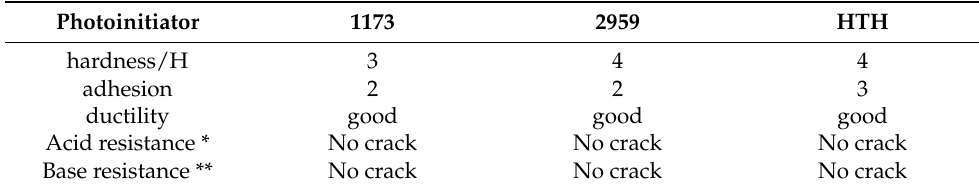
Table 2. Film properties.